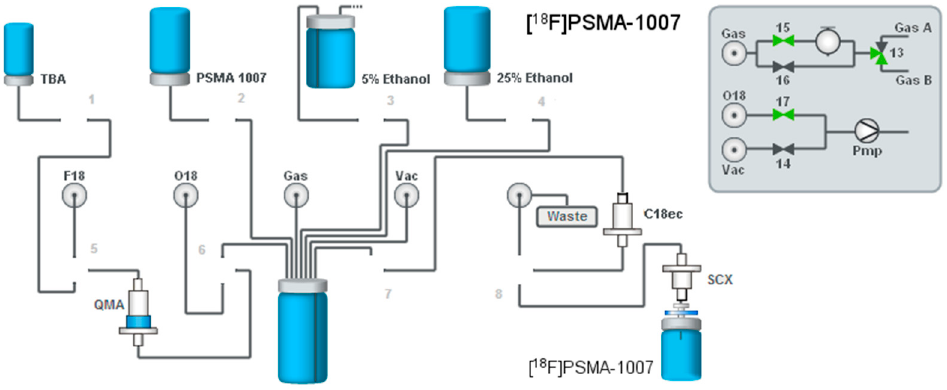
Figure 9. General setup of the radiosynthesiser for the one-step production of [ 18 F]PSMA-1007 with SPE cartridge purification on the IBA SYNTHERA+ system.